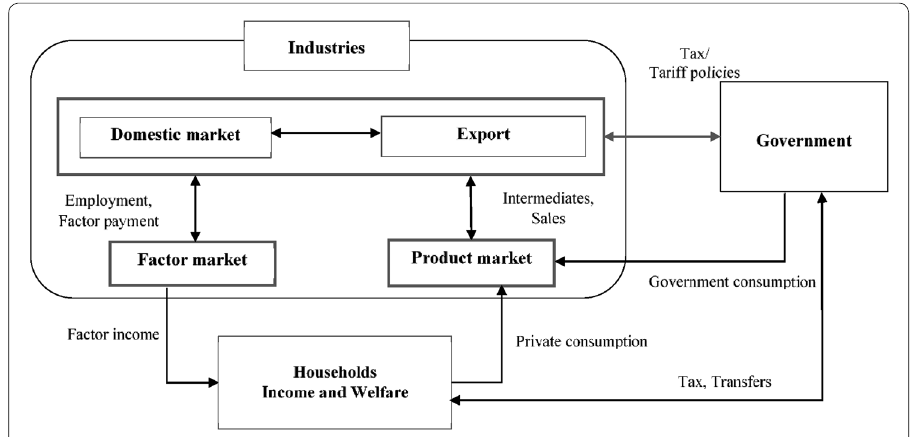
Fig. 3 Conceptual framework of the study. Source : Author’s creation, based on Ganuza et al.